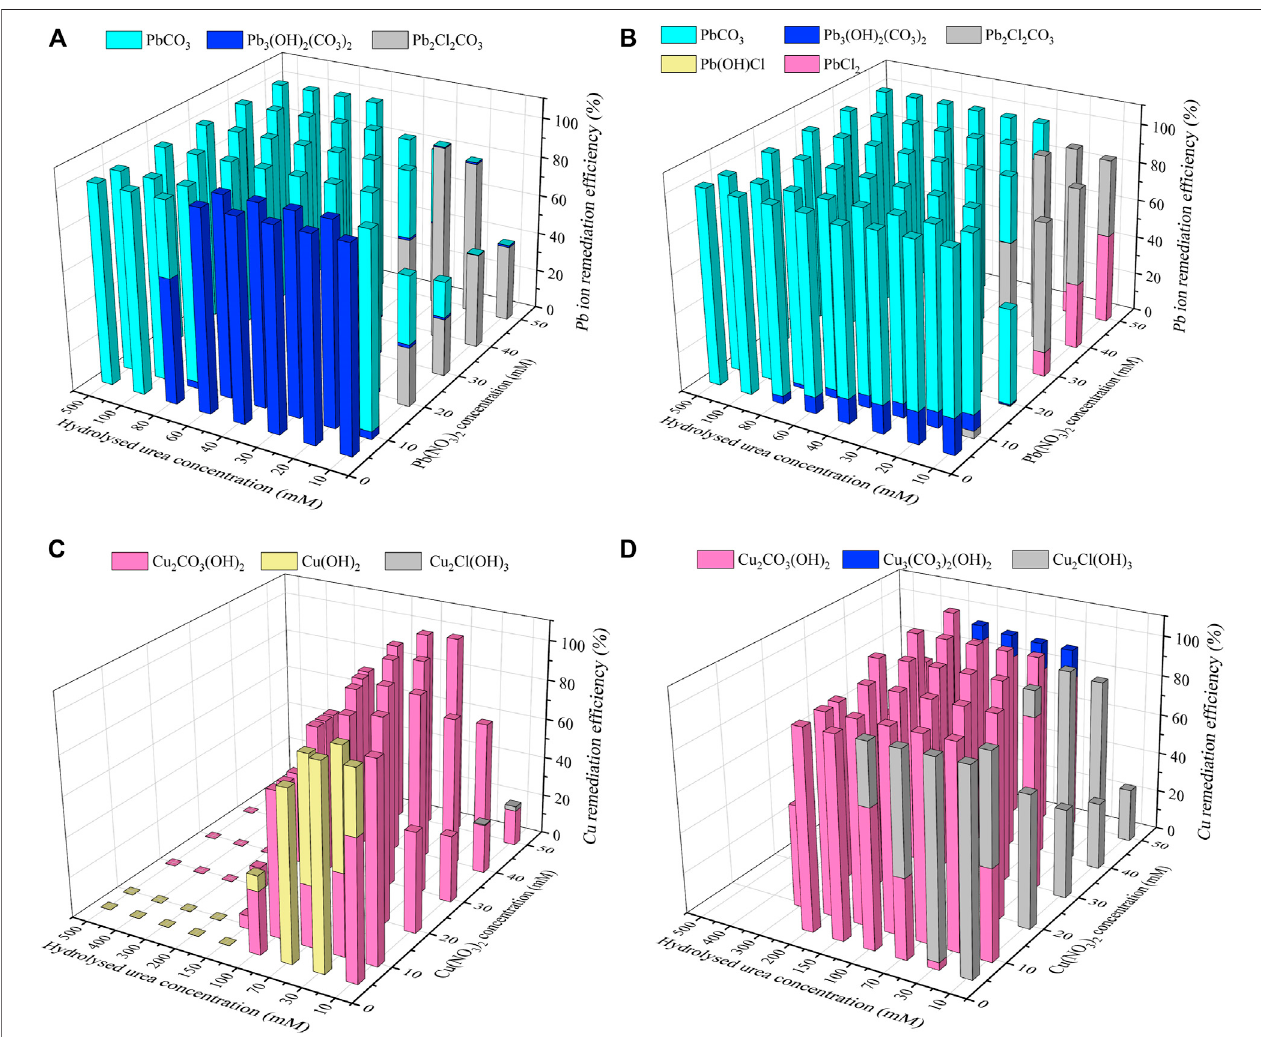
FIGURE 9 | Variations of the Pb remediation ef fi ciency against different Pb 2+ concentration ranges considering hydrolysed urea concentrations varying in a 10 – 100 mM: (A) no calcium source addition; (B) withCaCl 2 addition; variations ofthe Cu remediation ef fi ciency against differentCu 2+ concentration ranges considering hydrolysed urea concentrations varying in a 10 – 500 mM: (C) no calcium source addition; (D) with CaCl 2 addition.